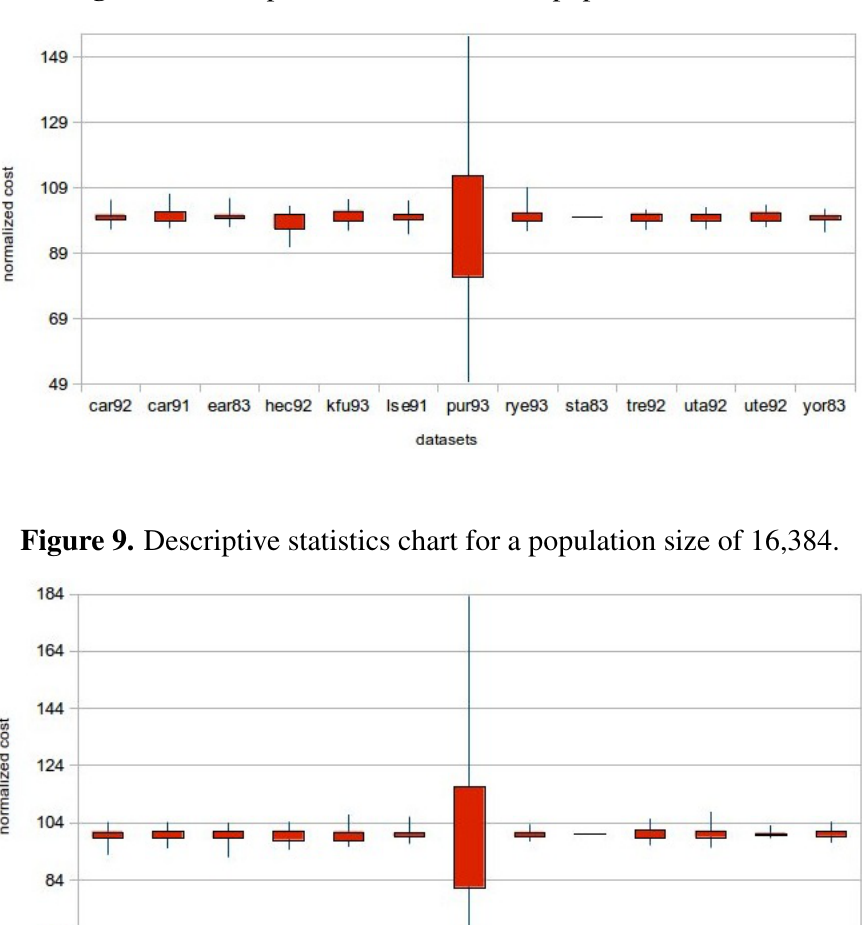
Figure 8. Descriptive statistics chart for population size 256.